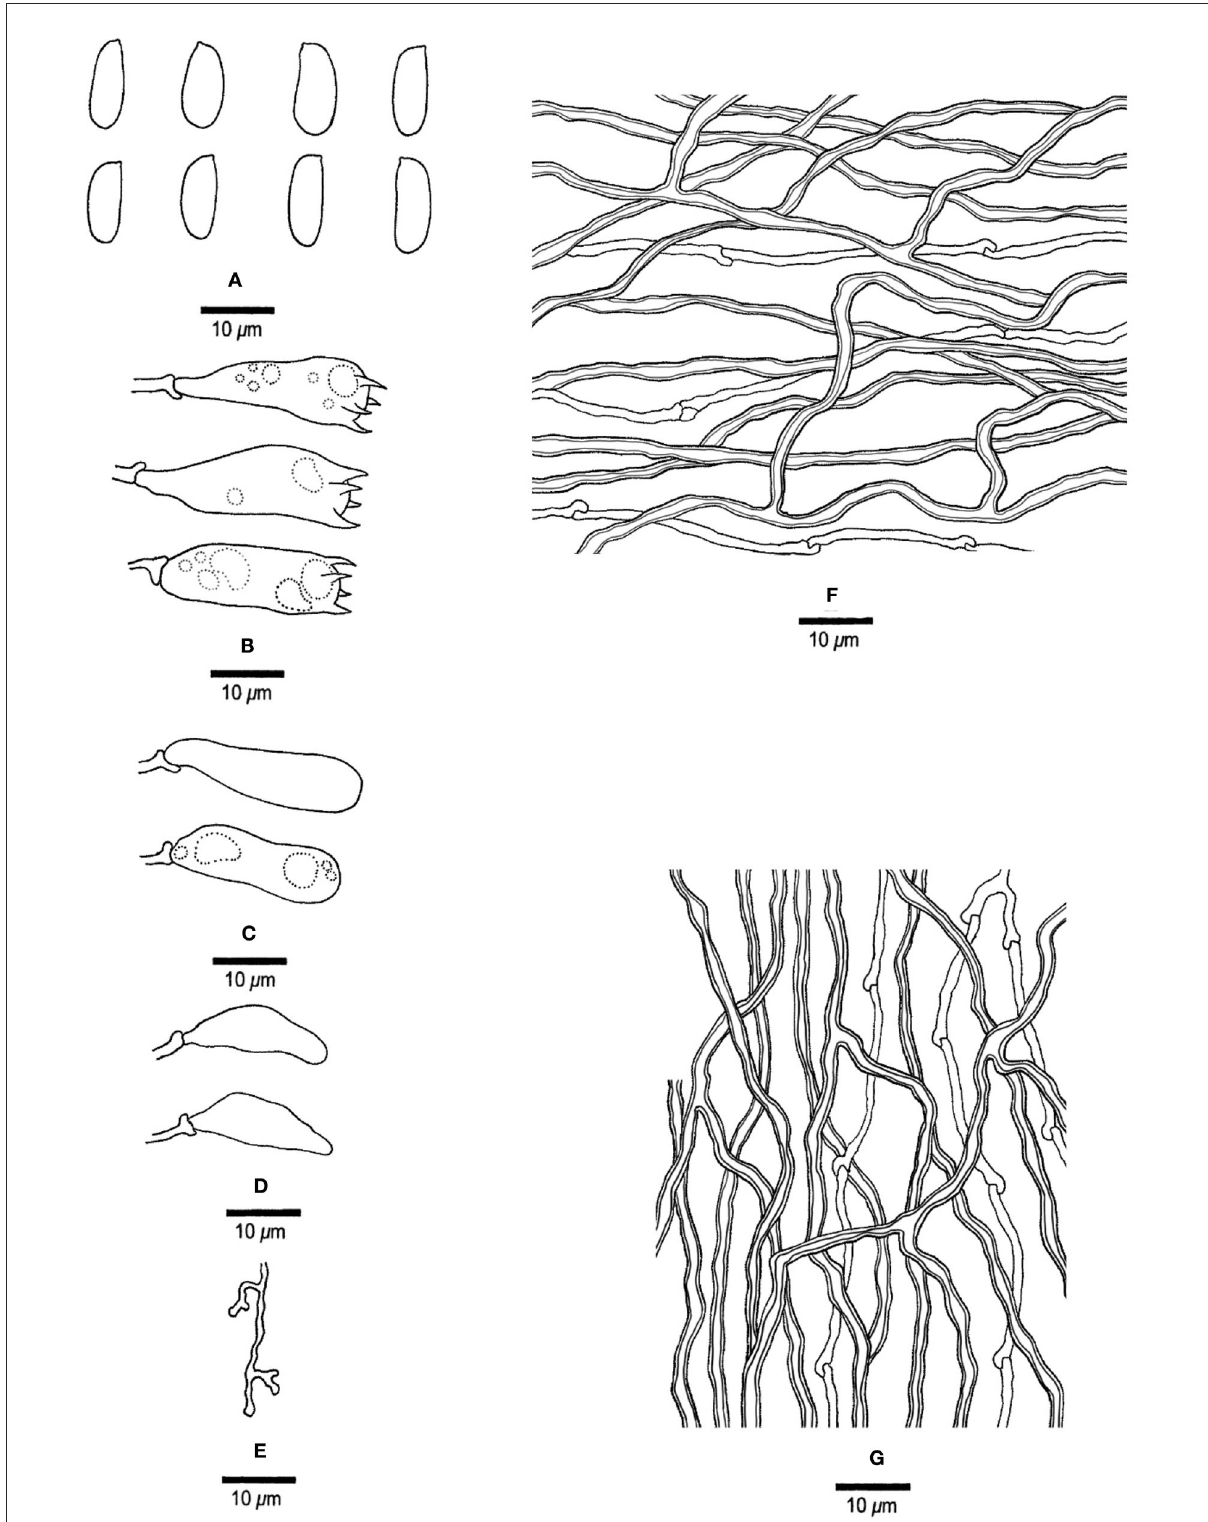
FIGURE16 Microscopic structures of Megasporia sp. 1 (drawn from JV 0904/52-J). (A) basidiospores, (B) basidia, (C) basidioles, (D) cystidioles, (E) dendrohyphidia, (F) hyphae from subiculum, and (G) hyphae from tube